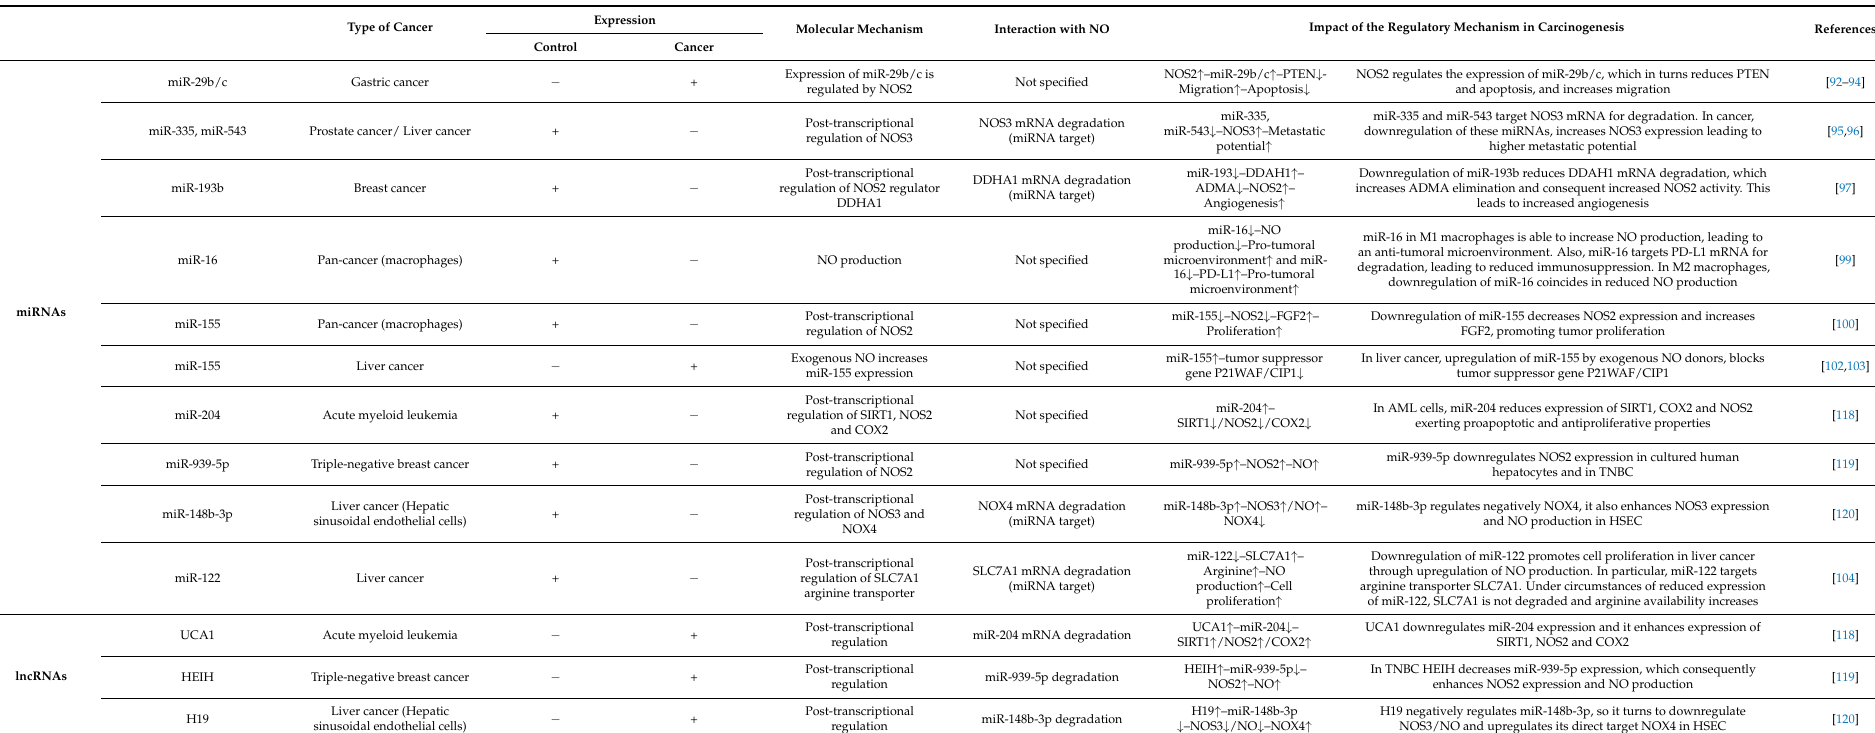
Table 2. Expression of miRNA and lncRNA in control and cancer. Low and high expression are indicated by “ − ” or “+”, respectively. Mechanisms linking cancer and NO are also